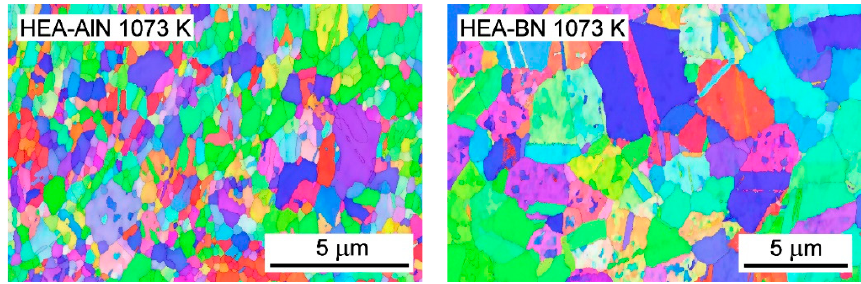
Figure 2. Microstructure of HEA-AlN ( left ) and HEA-BN ( right ) after a creep test at 1073 K. Examples of the time dependence of true compressive strain are given in Figure 3.